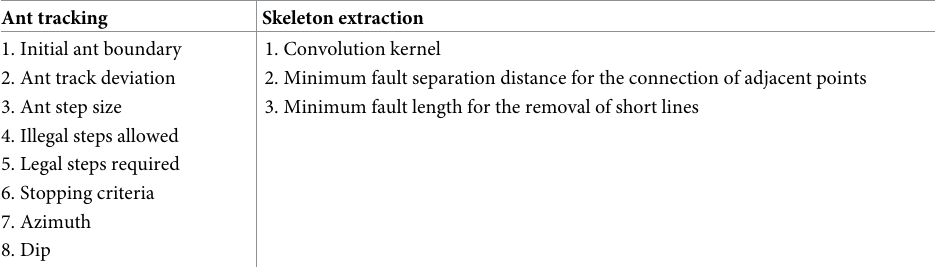
Table 1. Comparison of ant tracking and skeleton extraction